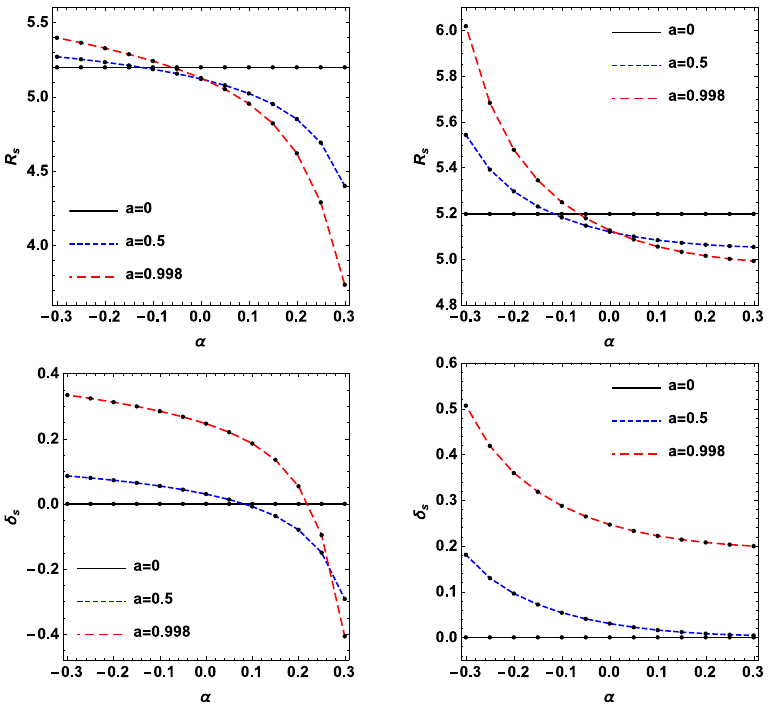
Figure 6 . The change of the black hole shadow size R s and the distortion parameter δ s with the coupling parameter α for the different rotation parameter a . The left and right panels correspond to the effective metrics (2.21) and (2.22), respectively.